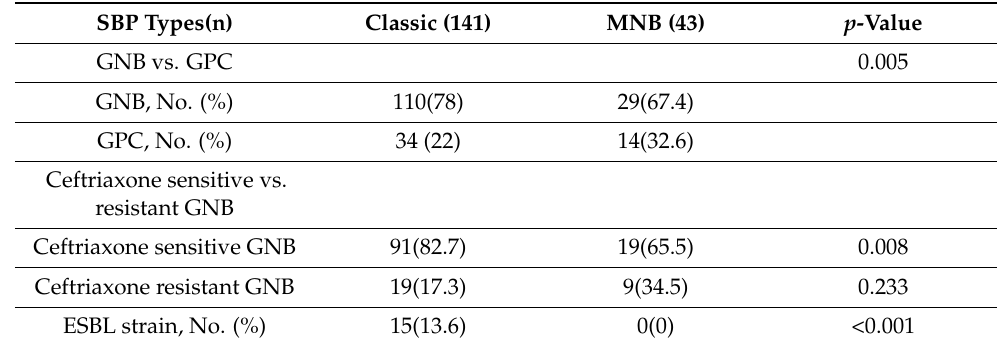
Table 4. Bacterial culture differences between classical SBP and MNB.